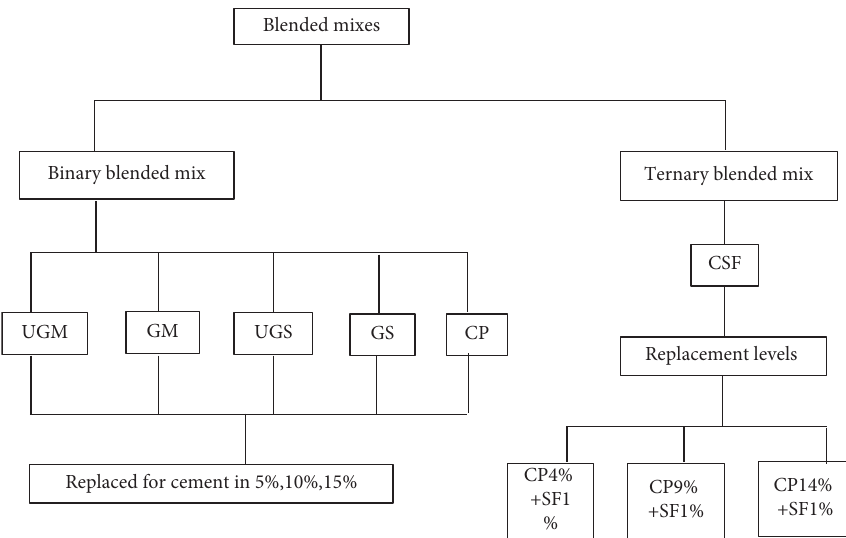
Figure 5: Pictorial representation of the mix proportions Table 2: Mix proportion: binary mix (cement and any one mineral admixture).